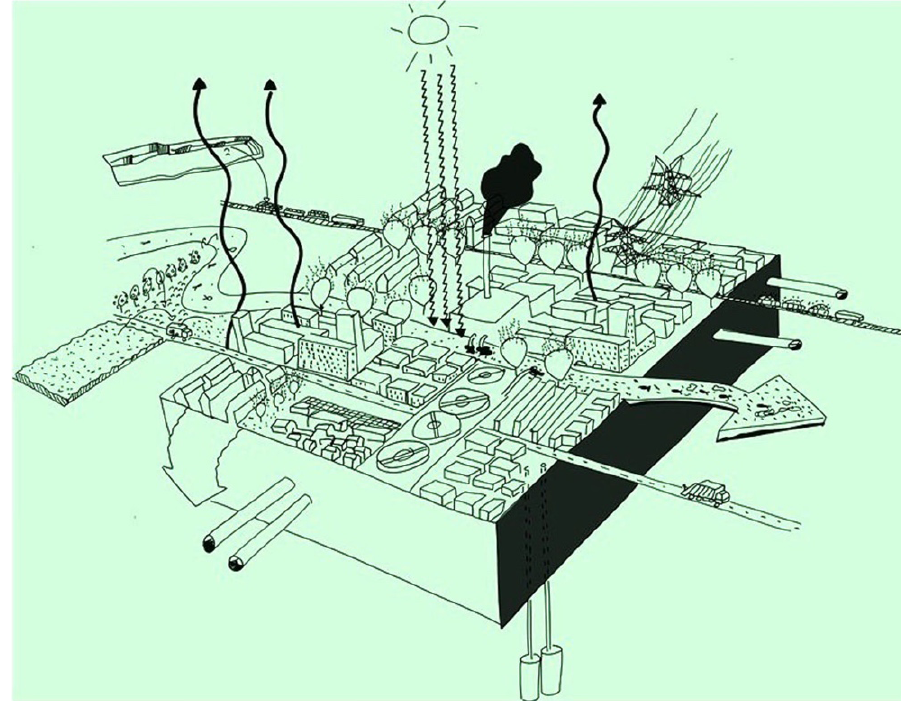
Figure 3. Urban metabolism model. Source: Dirk Sijmons/Jutta Raith (Gemeente Rotterdam et al., 2014). Urban Planning, 2019, Volume 4, Issue 1, Pages